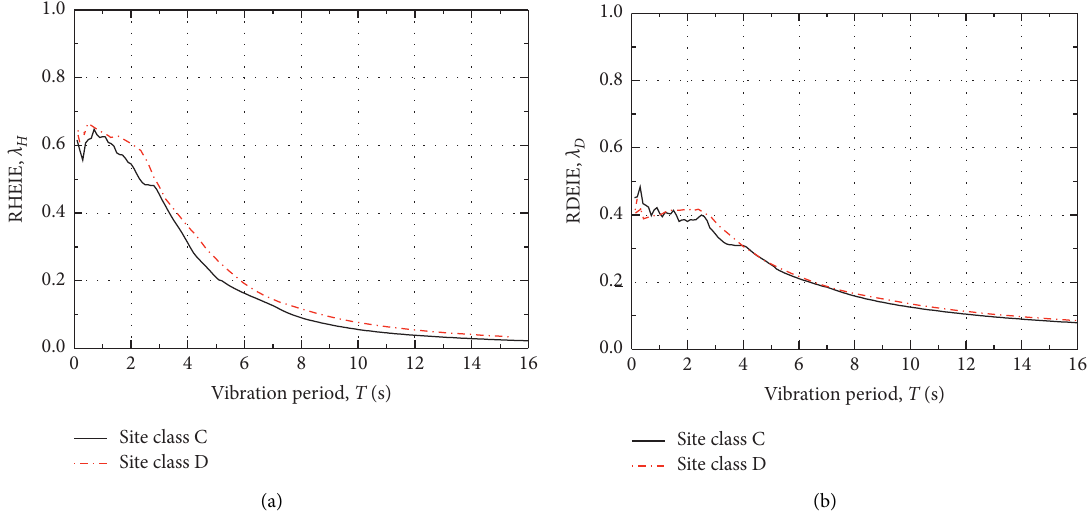
Figure 11: Energy distribution rule affected by site class under near-fault pulse-like ground motions. (a) RHEIE. (b)